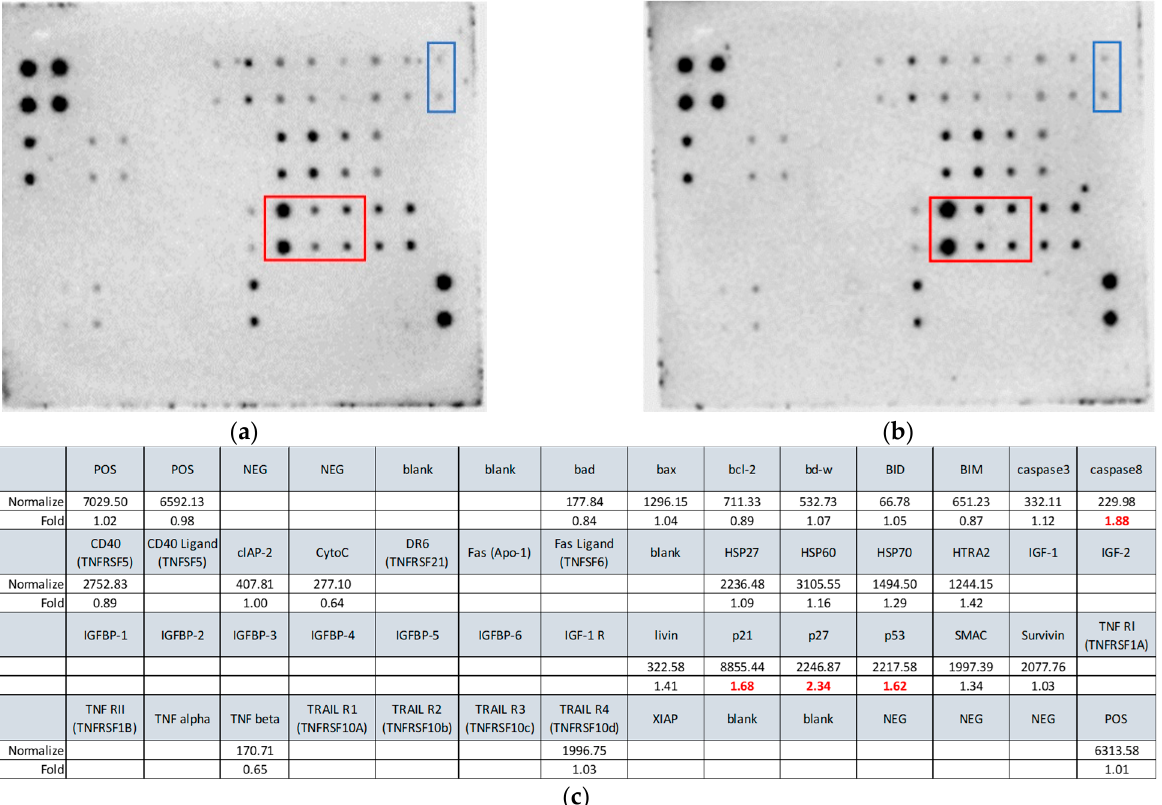
Figure 5. Expression of apoptosis-related proteins in the control and o-GQD-treated cells, meas- ured using the apoptosis protein membrane array. Red box: (from left to right) p21, p27, and p53. Blue box: Caspase 8. ( a ) Control group cells; ( b ) o-GQD-treated cells (2.5 mg/L); ( c ) Apoptotic proteins and their expression ratios between pre-treated and post-treated cells. The position of the square in the figure and the protein name and expression level listed in the square correspond to the protein position on the protein membrane array (black dots).